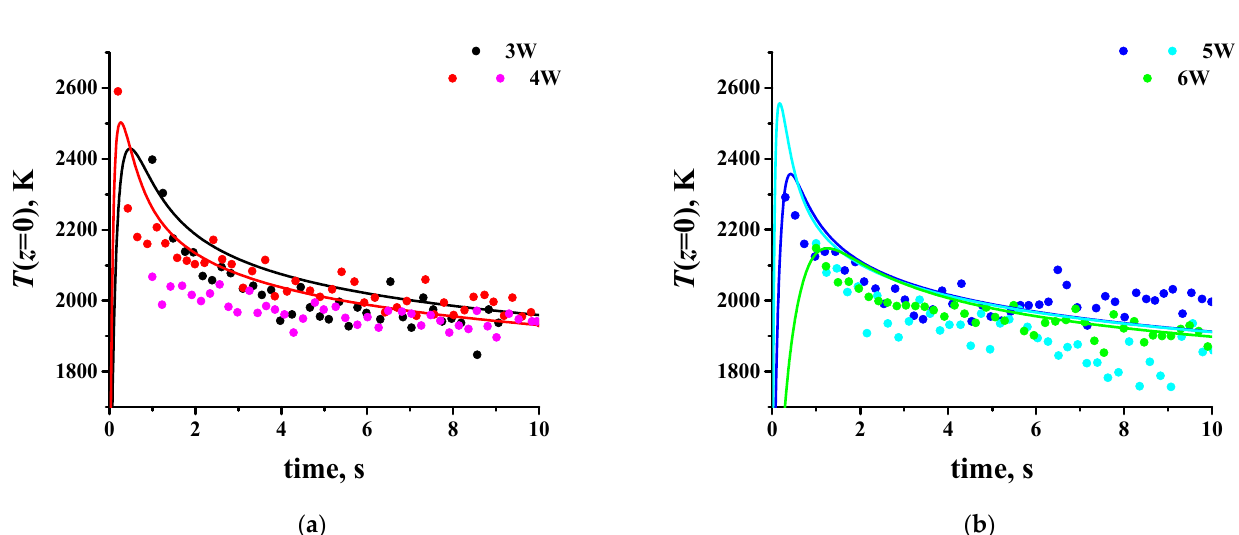
Figure 2 . The dots show the experimentally measured SAC temperature for different laser powers P : ( a ) 3 W (black) and 4 W (red and magenta); ( b ) 5 W (blue and cyan) and 6 W (green). For comparison, the curves show the theoretical dependence of the SAC temperature on time, calculated according to the model presented in the text below, for the same values of laser radiation powers.